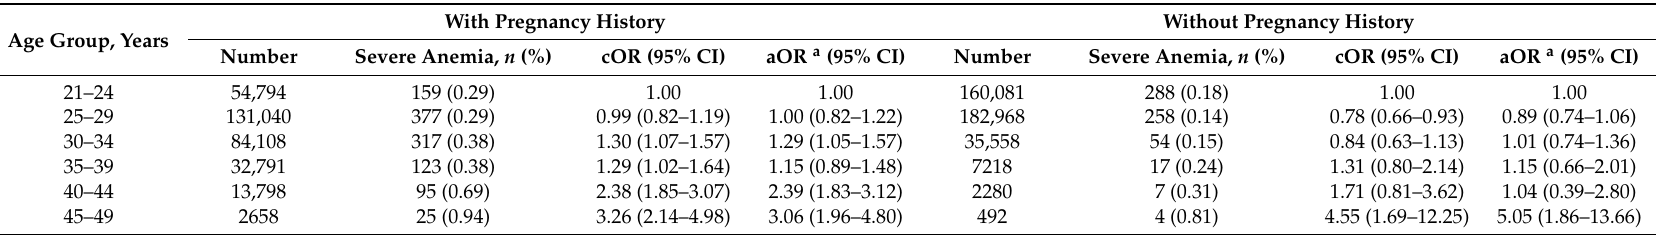
Table 4. Prevalence of severe anemia in different age groups among non-pregnant women of reproductive age, stratified by the history of pregnancy in 2012, rural